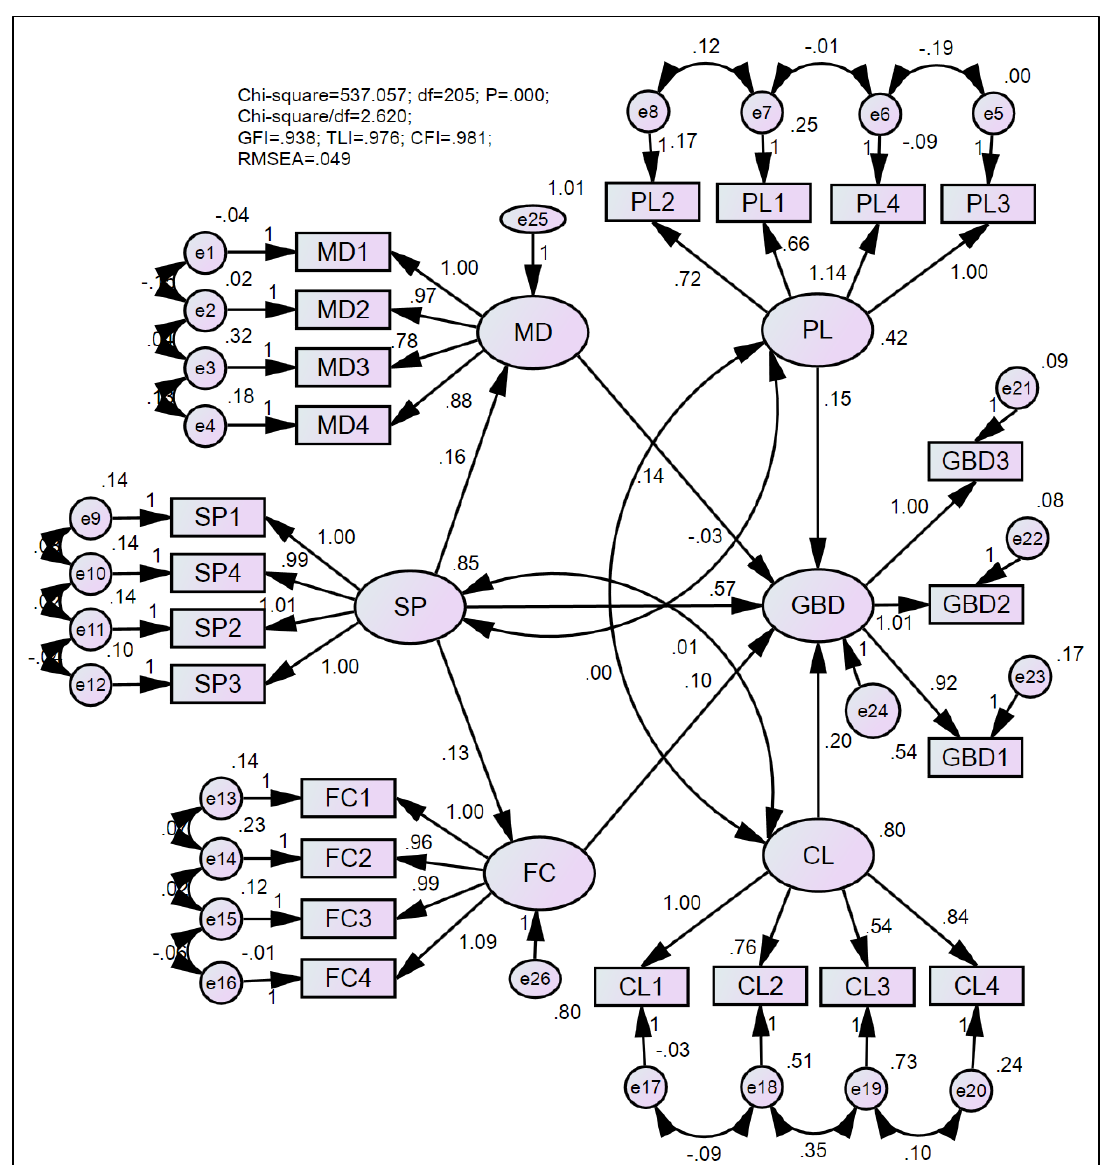
Figure 5. Testing factors affecting the green bank